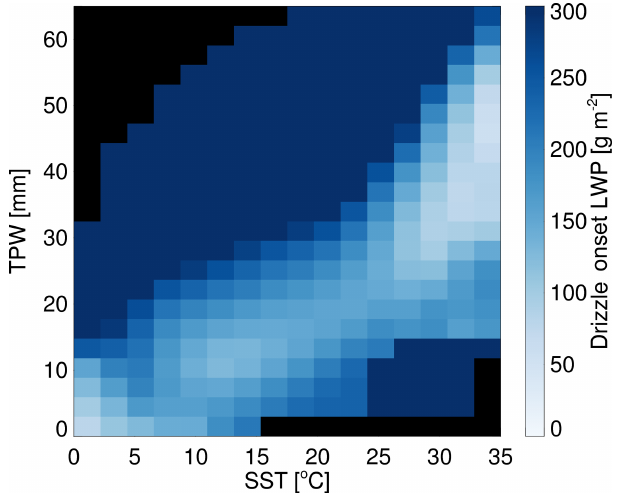
Figure 1. Drizzle onset value of LWP, separated by SST and TPW. Regimes with little data are assigned the maximum value, 300gm − 2 , in line with Wang et al. (2017), while regimes with no data are given in